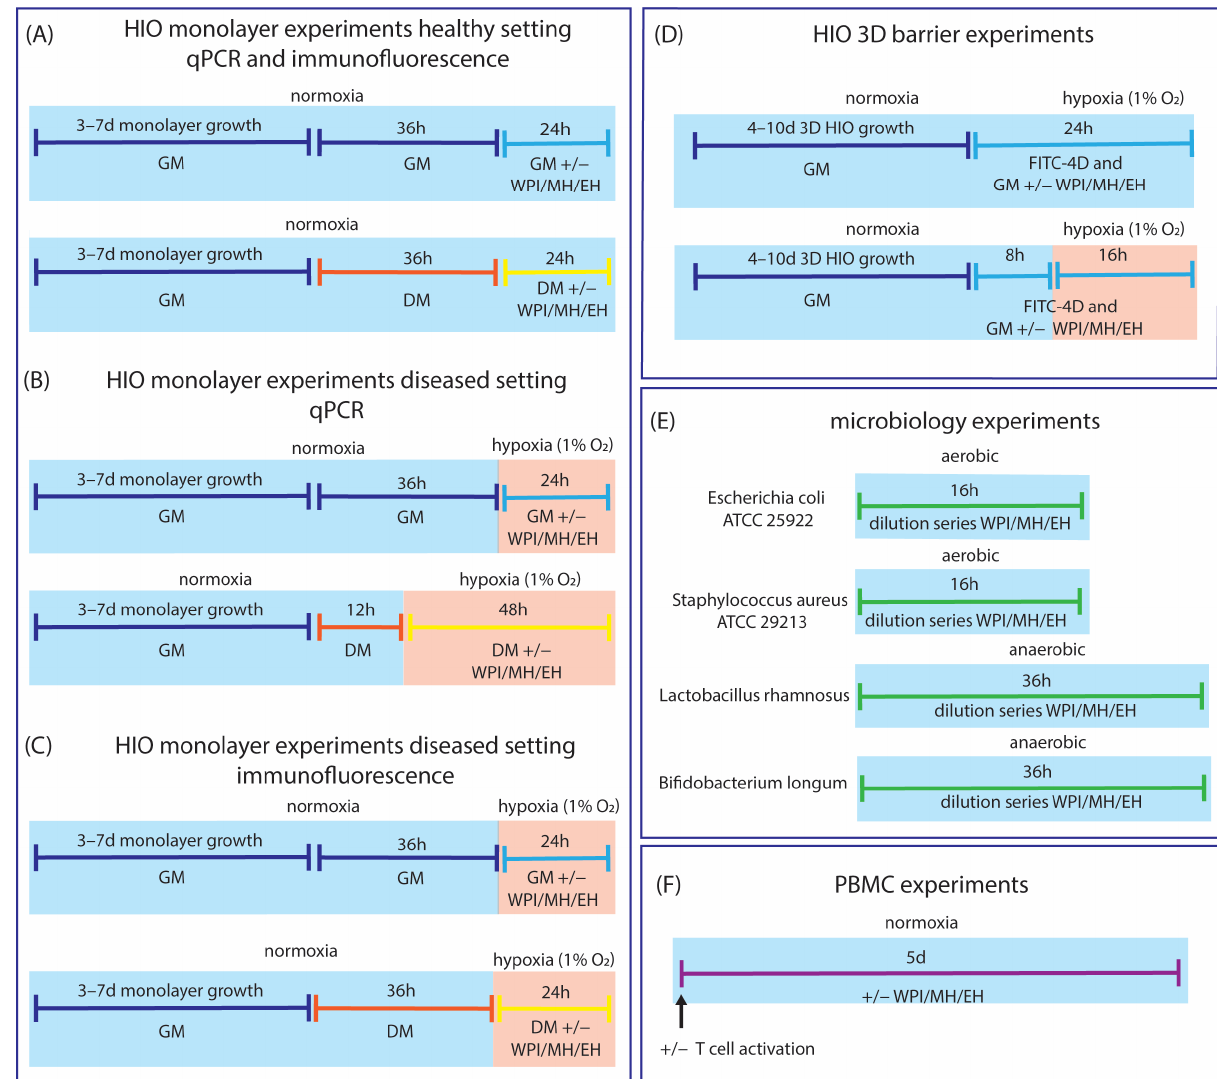
Figure 1. Experimental set-up of the different experiments performed. Light blue blocks indicate physiological culture conditions; light red blocks indicate a diseased (hypoxic) setting. Dark blue lines indicate use of GM; light blue lines indicate use of GM with added WPI, DH28, or DH51; orange lines indicate the use of DM; yellow lines indicate use of DM with added WPI, DH28, or DH51; green lines indicate the use of the appropriate culture medium for microbiology experiments; and purple line indicates the use of the appropriate culture medium for PBMC experiments. ( A ) For HIO monolayer experiments in a healthy setting (normoxia) analyzed by qPCR and immunofluorescence, HIO monolayers were cultured for 3–7 d prior to the onset of the experiment. At start of